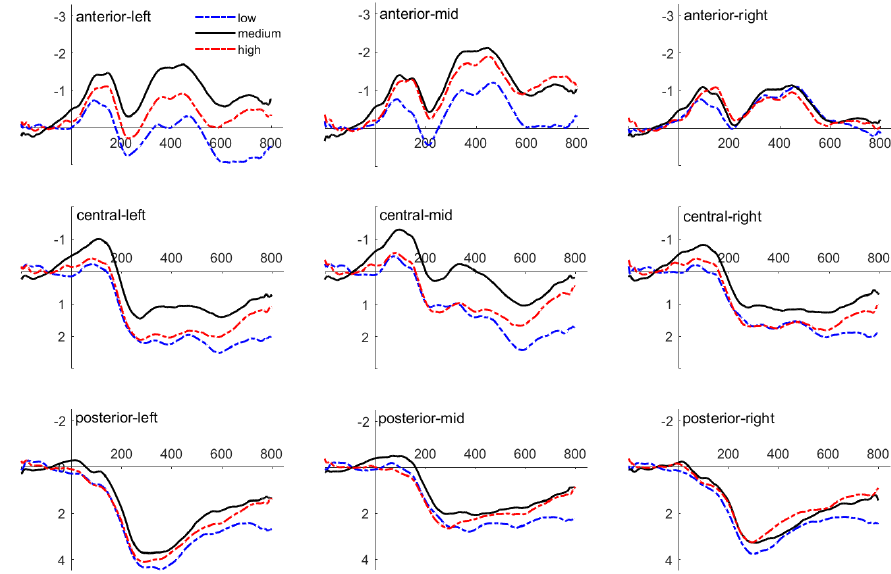
Figure 5. Grand average ERPs plotted for the low‑cure rate condition.